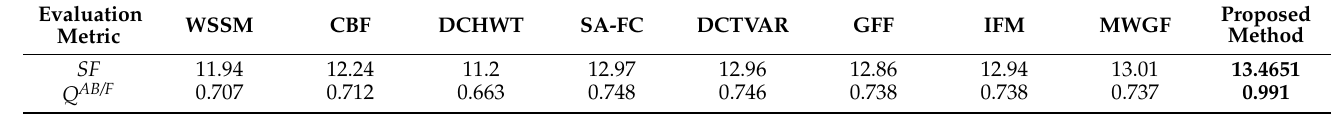
Table 29. The outcomes for the lab image and comparisons with existing techniques in the literature